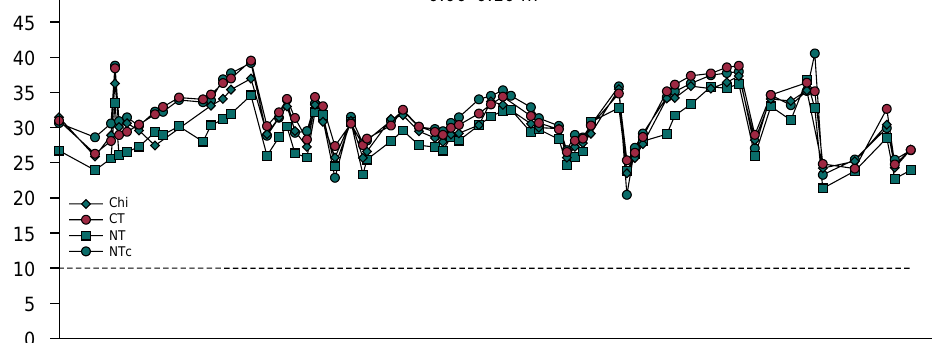
Table 6. Maximum bulk density for 1600 kPa in uniaxial compression and degree of compaction in three soil layer and four tillage methods at physiological maturity of cassava crop Treatments Layers Chi CT NT NT C